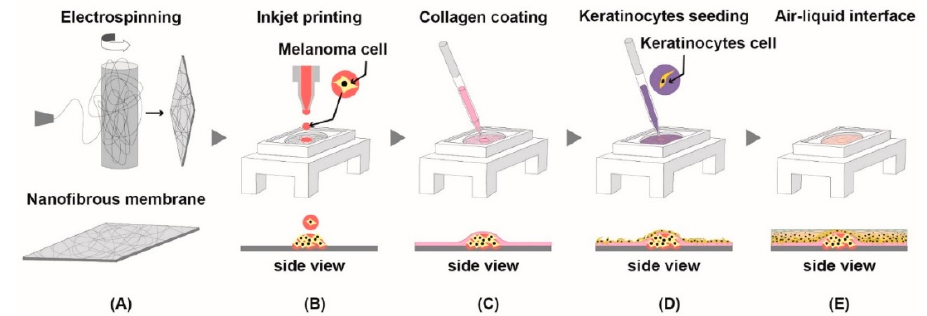
Figure 4. The process of making a 3D melanoma model. ( A ) Fabricating a nanofibrous membrane using electrospinning. ( B ) Printing and forming cell aggregation of human melanoma cells (A375P) using a micro dispensing system. ( C ) Coating the nanofibrous membrane with collagen. ( D ) Seeding the normal human epidermal keratinocytes on the membrane. ( E ) Air-liquid interface culture.